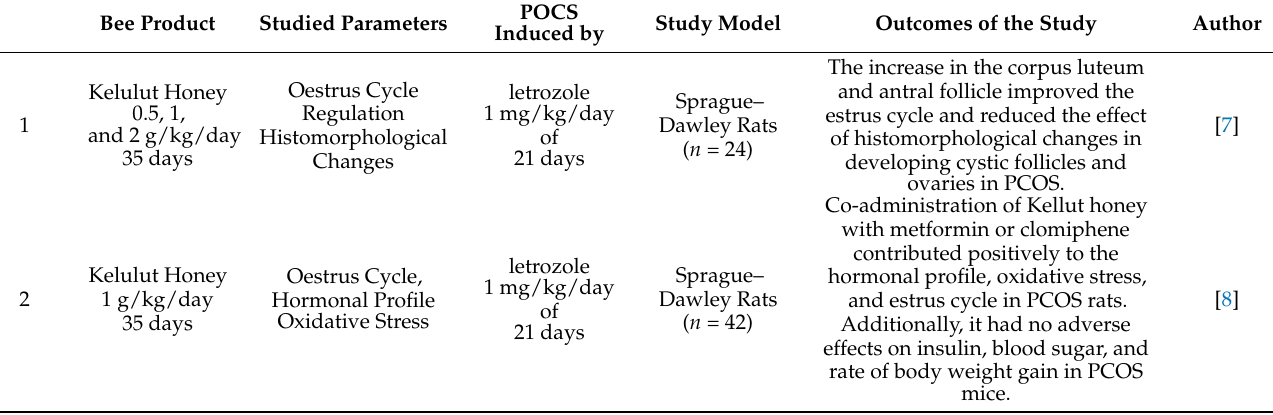
Figure 2. PRISMA (Preferred Reporting Items for Systematic Reviews and Meta-Analyses) flow diagram for data extraction. Table 1. Summary of studies carried on the use of bee products in treatment and/or management of PCOS